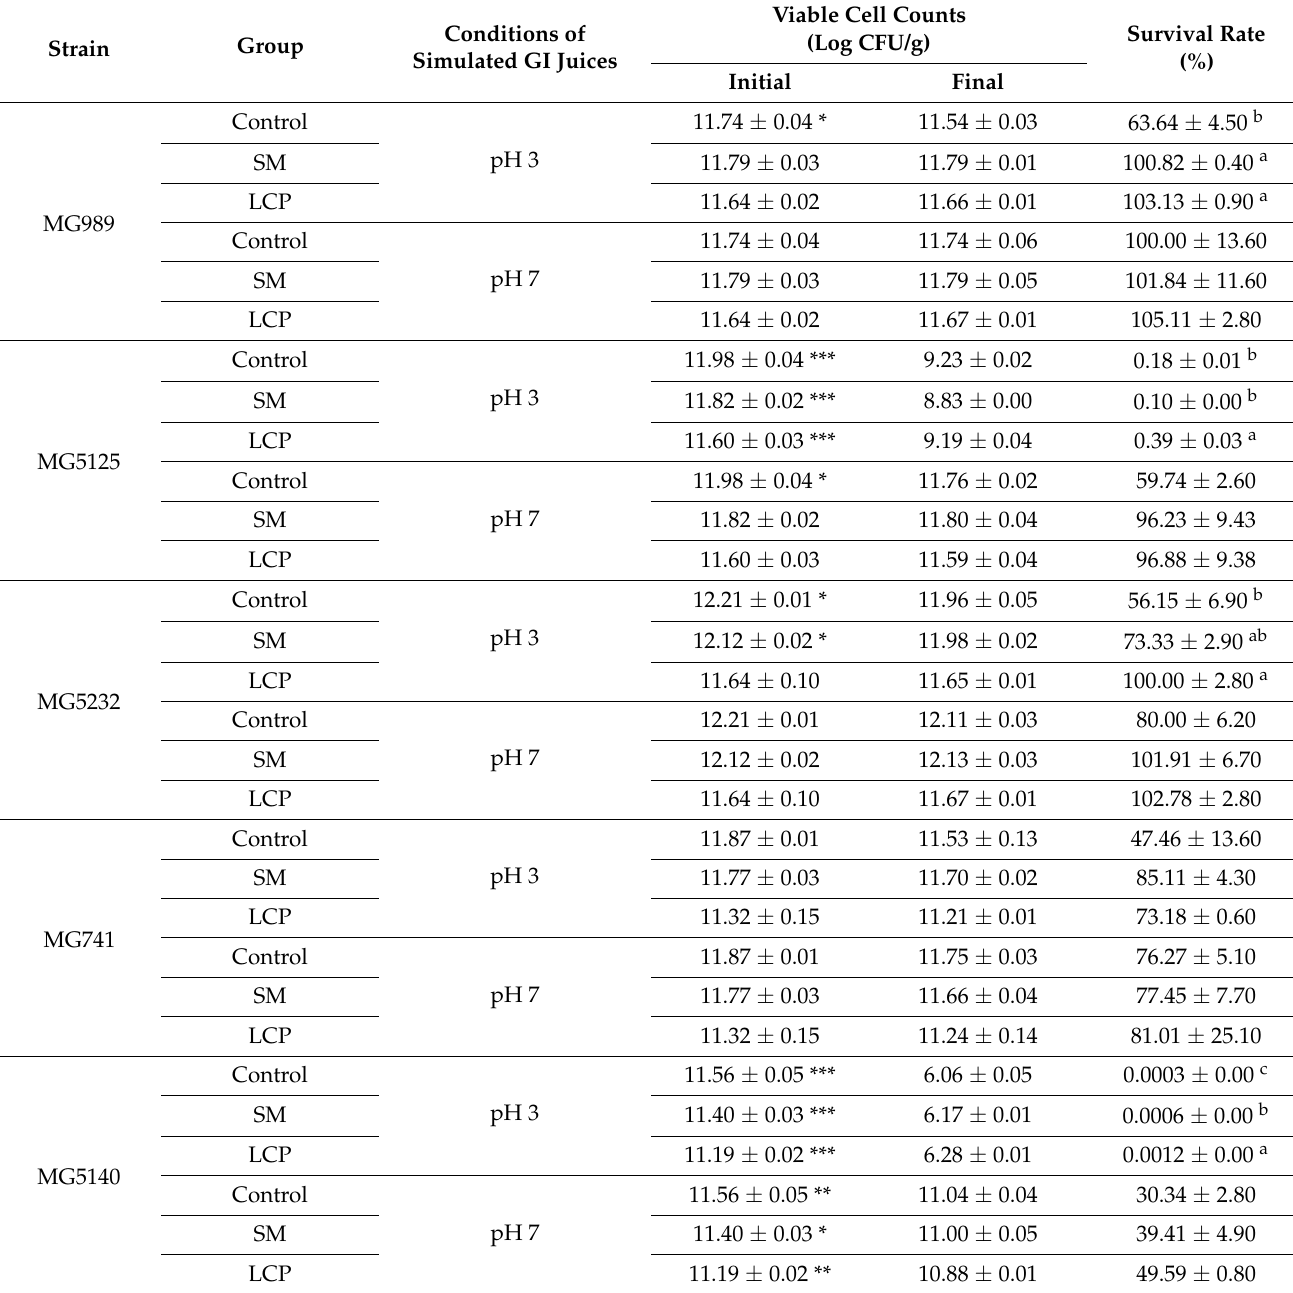
Table 2. Cell viability of the probiotic bacterial strains under the simulated GI conditions at pH 3 and